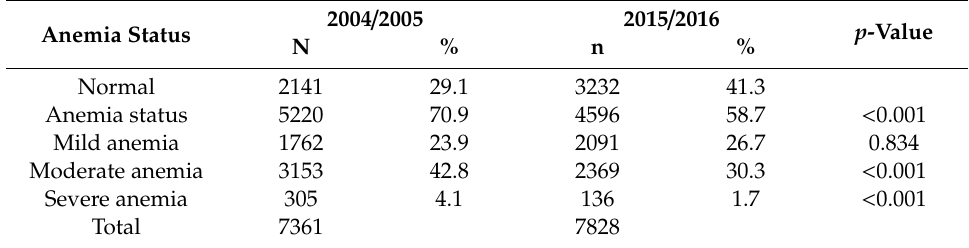
Table 1. The prevalence of anemia among children under 5 in